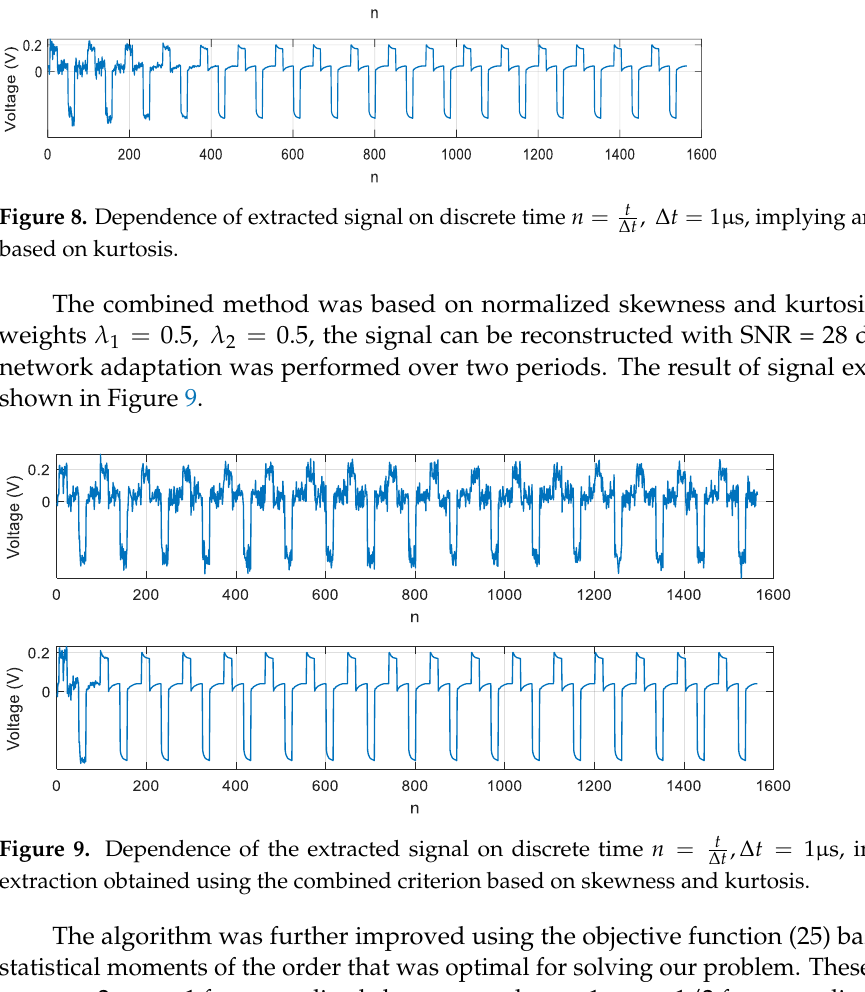
, ∆ t = 1 µ s, implying an t